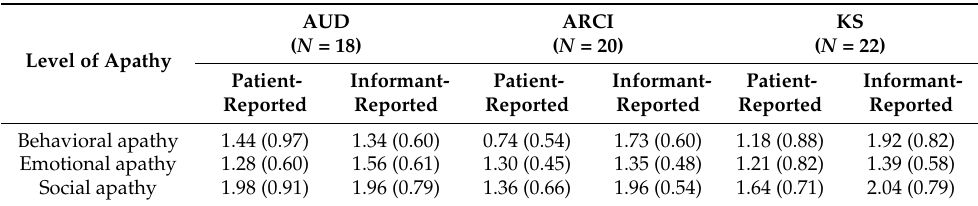
Table 3. Mean ratings and standard deviations of patient-reported and caregiver-reported apathy assessed using the apathy motivation index for the patients with alcohol use disorder (AUD), alcohol- related cognitive impairments (ARCI) and Korsakoff’s syndrome (KS) for whom both versions were